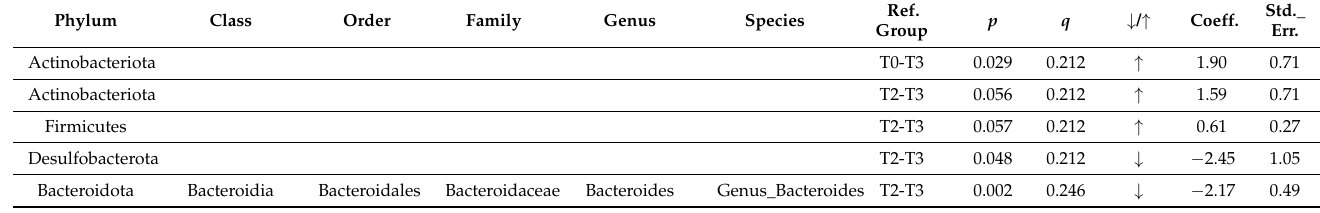
Table 5. Changes in gut microbiota taxa abundances between timepoints in the MEDI group.